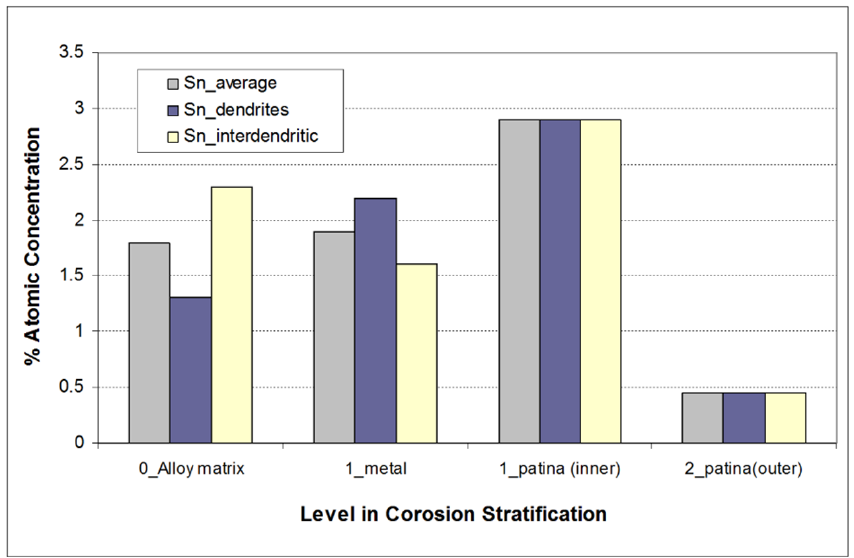
Figure 16. % Sn atomic concentration profile of the corrosion layer stratification in dendritic and interdendritic areas after ZB anodic polarization in 0.1 mol/L NaCl—Based on EDS elemental chemical analyses data (fullframe and spot analyses).